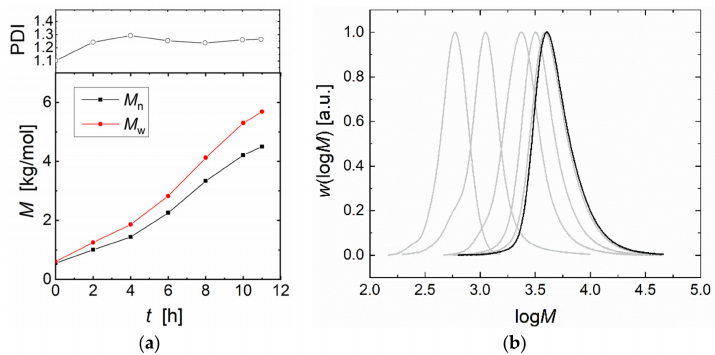
Figure 4. Development of polydispersity index (PDI) ( a ) and molecular weight distribution (MWD) curves ( b ) of PPECs synthesized at 10 bar CO 2 and 120 ◦ C in semi-batch mode (0.3 mL / min PO feed) in a 450 mL autoclave and with Lupranol 1200 as CTA (Entry